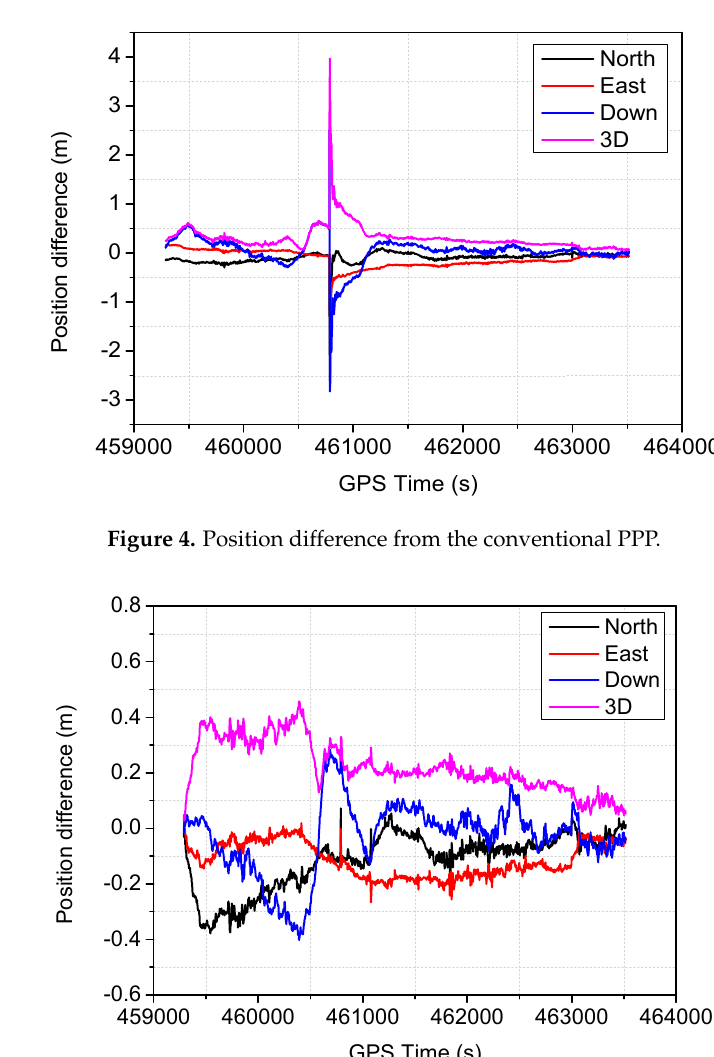
Figure 5. Position difference from the fixed PPP/INS.